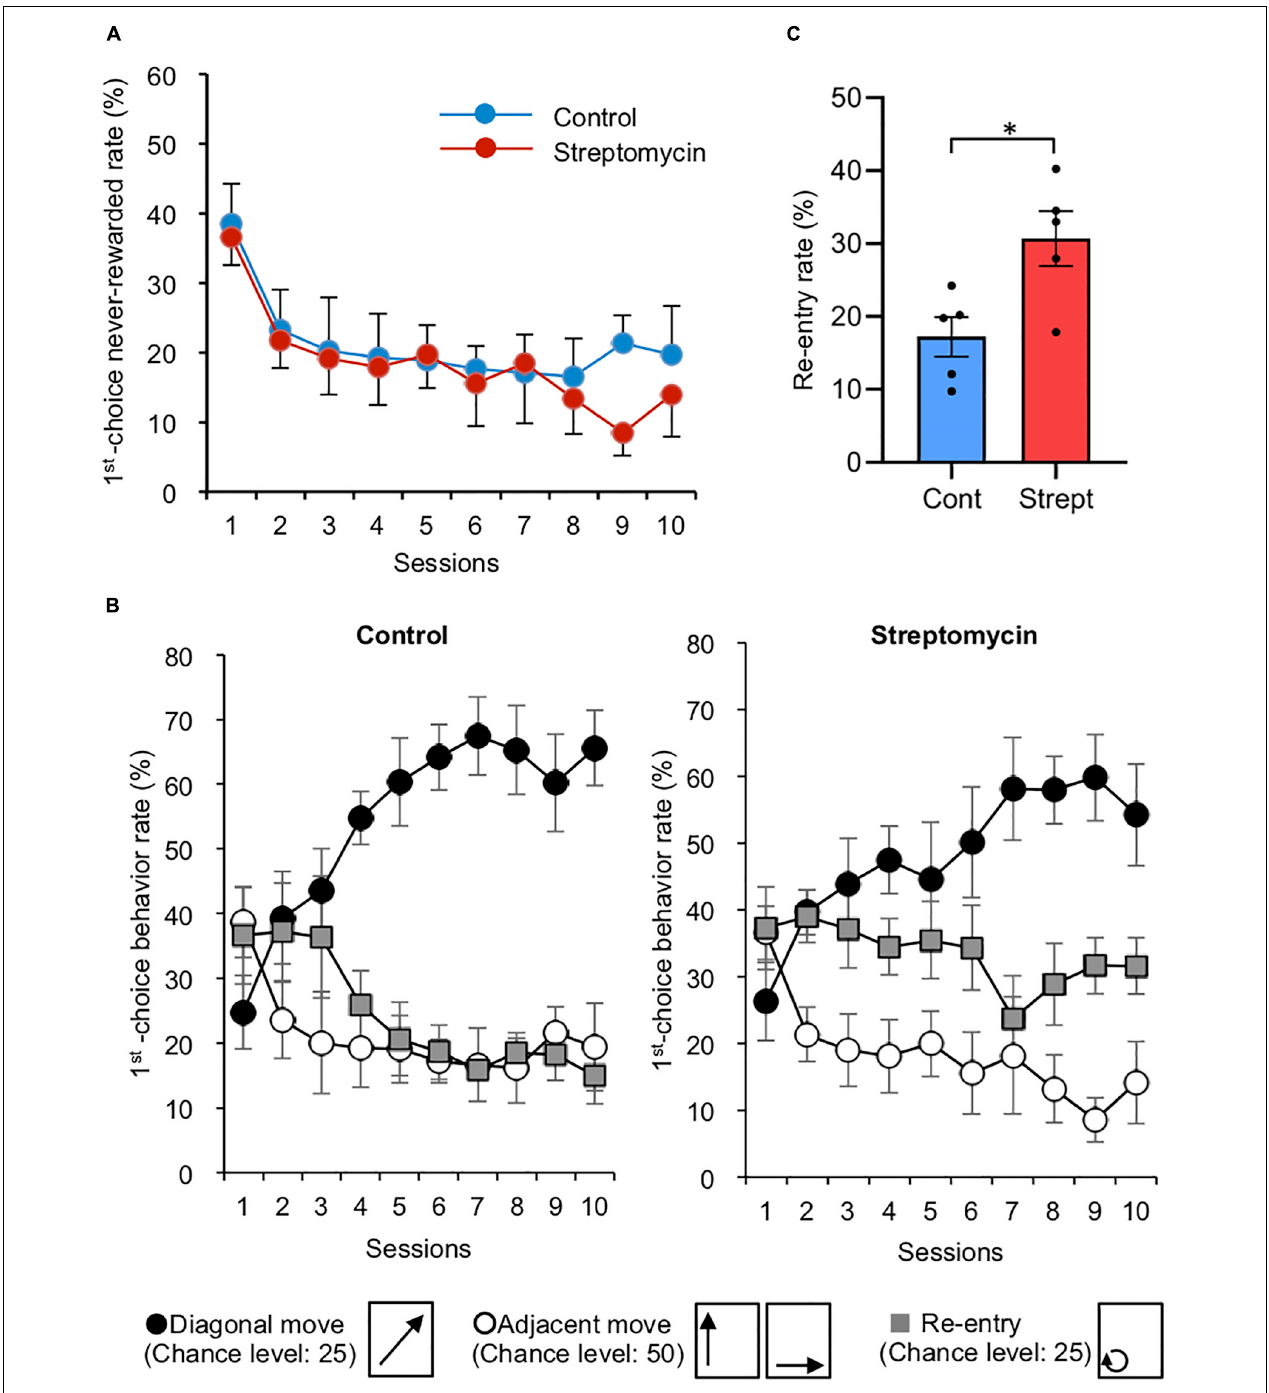
FIGURE 2 | Effects of streptomycin treatment during acquisition phase (sessions 1–10). (A) Change in first-choice never-rewarded rate ( n = 5/group). Error bars represent standard error of the mean (SEM). This rate was defined as the number of nose-pokes to the two never-rewarded points (described in Figure 1E ) within the first 100 trials in each session, which makes the chance value of this error rate 50%. (B) The rates of the three move patterns in nose-poking of two consecutive points during the acquisition phase ( n = 5/group). These movements were classified as follows: (1) diagonal move, (2) adjacent move (move to either of two adjacent points), and (3) re-entry to the same corner. Thus, chance values are calculated as 25, 50, and 25%, respectively (these movements are shown below the graph). Error bars represent SEM. (C) Re-entry rate (%) of average of final three sessions of acquisition phase. ∗ p < 0.05 by Student’s t -test.